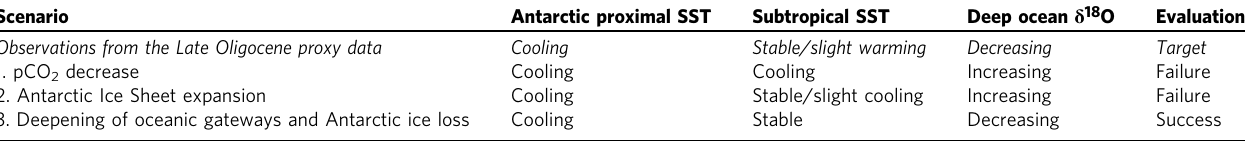
Table 1 Scenarios to explain Late Oligocene trends in SST and deep sea δ 18 O.